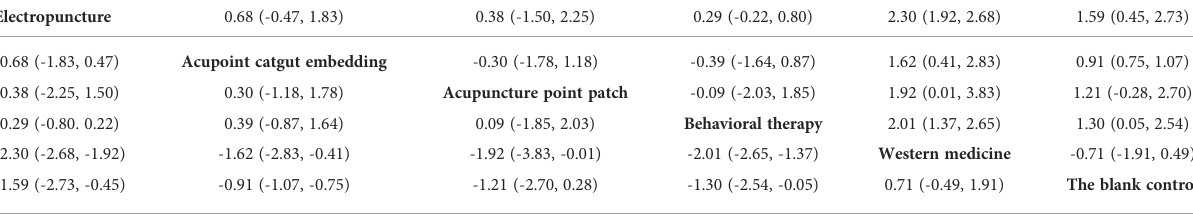
TABLE 5 Network meta-analysis ladder table of homeostasis model assessment — insulin resistance. Electropuncture